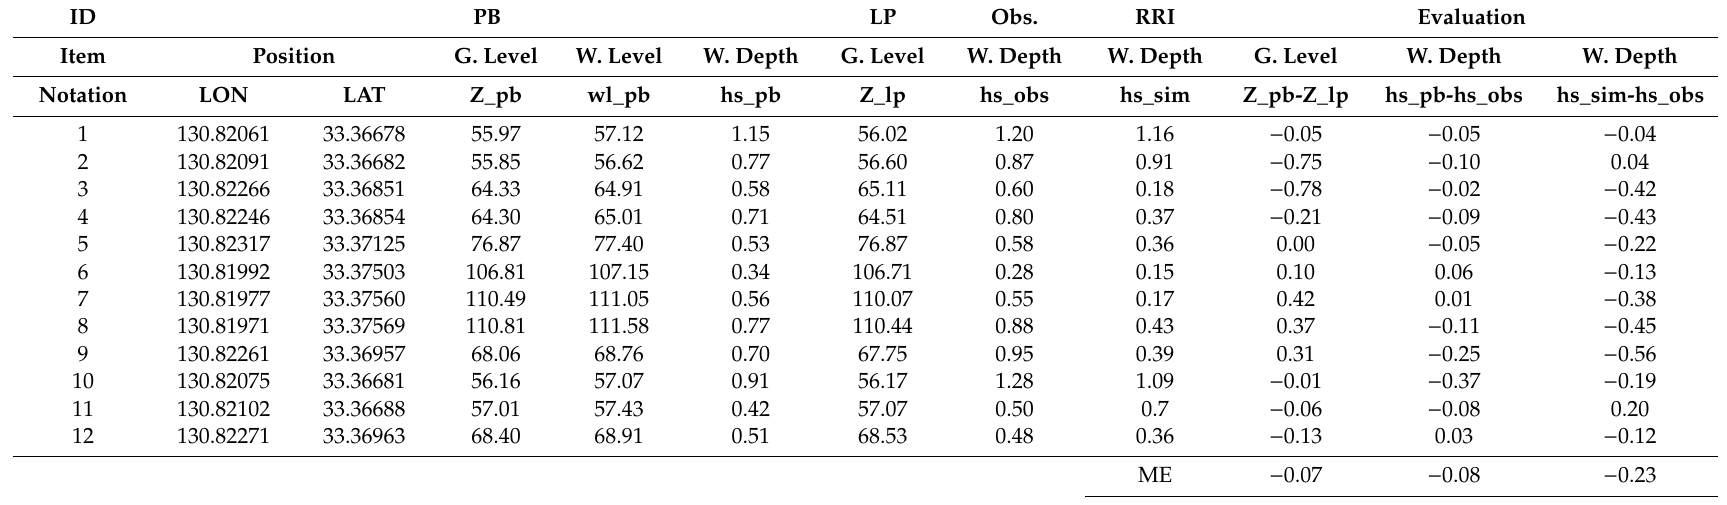
Table 2. Comparison of ground elevation (Z), inundation depths (wl), and field survey (obs) after the disaster, as measured by